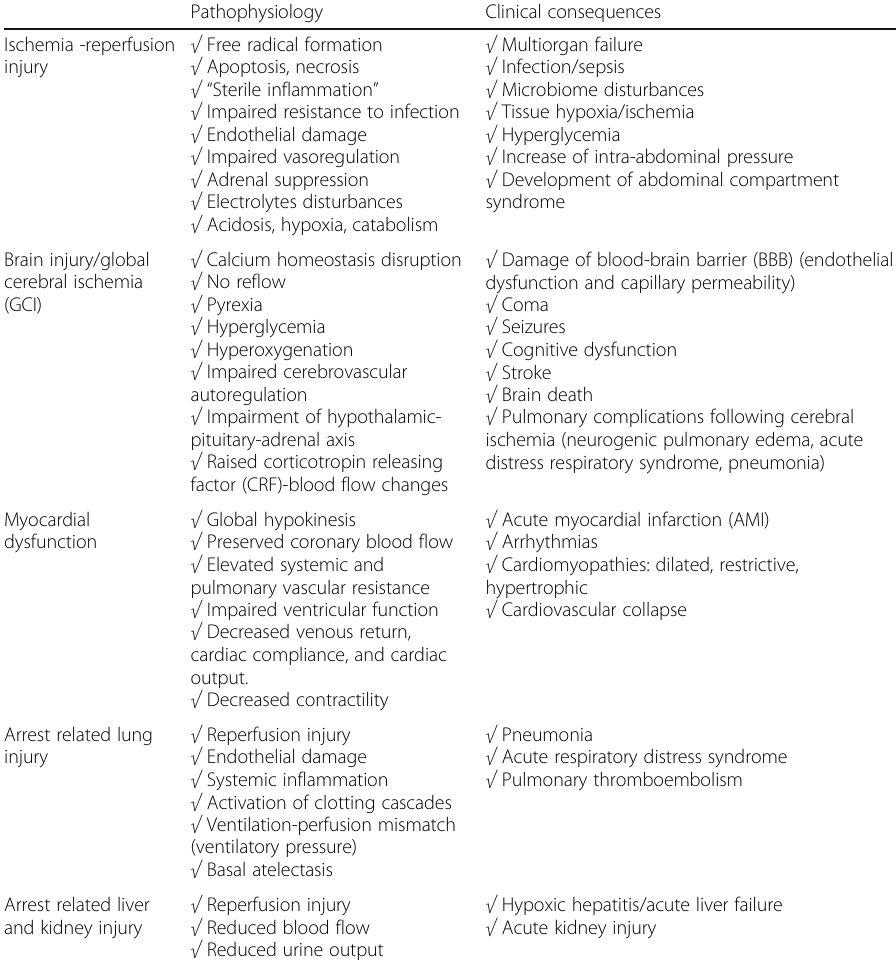
Table 1 Systemic consequences of cardiac arrest Pathophysiology Clinical